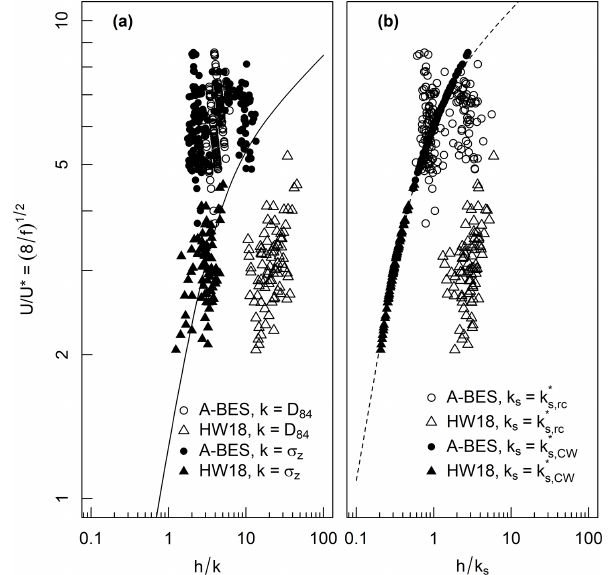
Figure 9. Plot of (8 /f ) 1 / 2 against relative submergence for A-BES and Hohermuth and Weitbrecht (2018) data, using four different roughness lengths ( D 84 , σ z , k ∗ s, rc , k ∗ ). The solid line is the s, CW Ferguson (2007) VPE using coefficients a 1 = 3 . 94 and a 2 = 1 . 36 determined by a systematic review of σ z as a roughness measure (Chen et al., 2020). The dashed line is the VPE fitted to the h/k ∗ s, CW data, yielding coefficients of a 1 = 7 . 22 and a 2 = 11 .